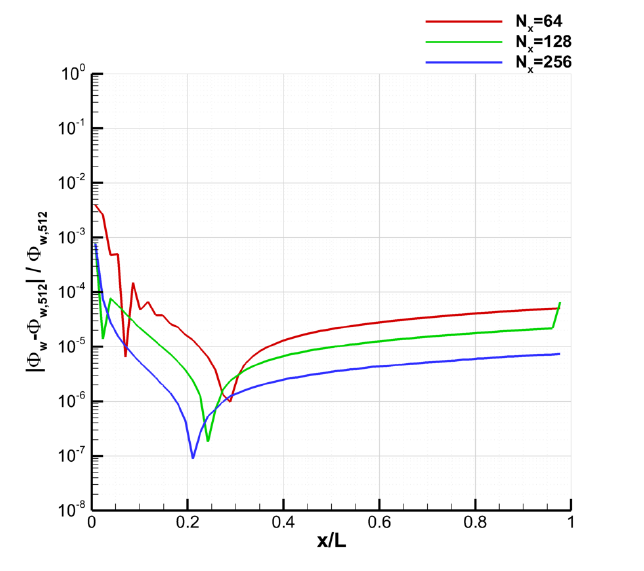
Figure 6. Relative error in φ w for N x = 64 to N x = 256. Test case 1, N =